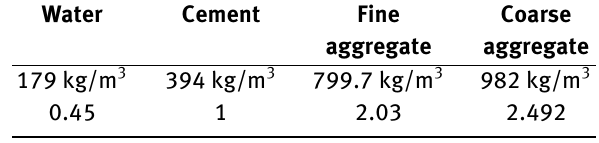
Table 3: Mix ratio used for beams casting.